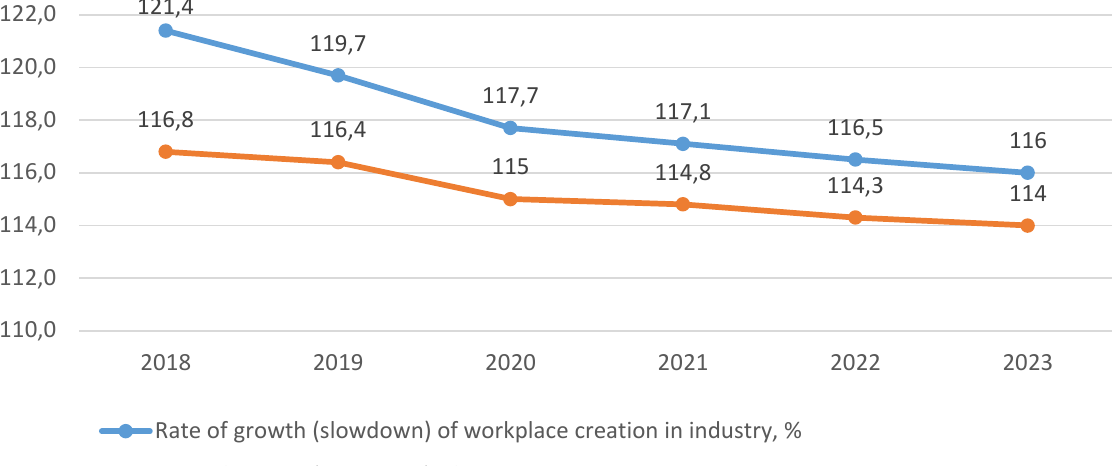
Figure 3. Forecasting of the new workplaces in industry as a whole and in the processing industry during 2018–2023